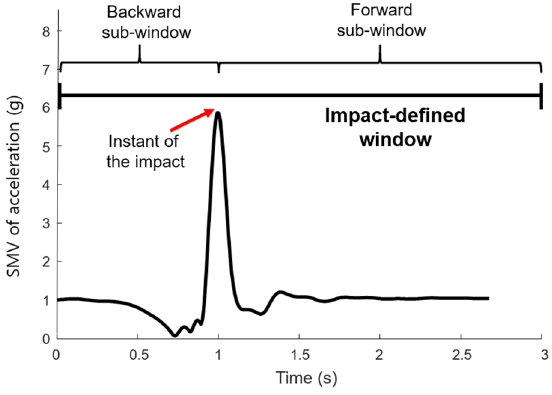
Figure 5. Impact-defined window.